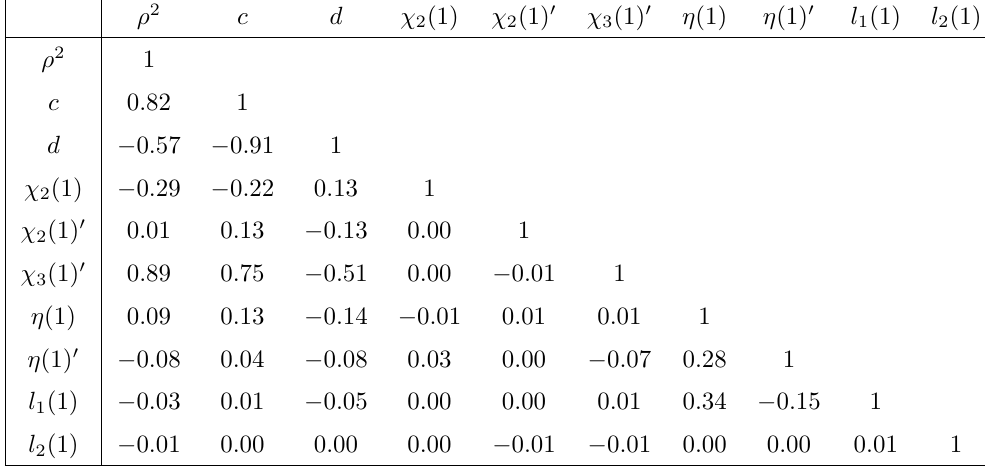
Table 11 . Correlation matrix of the inputs in table 1, used to determine the form factors in the HQET